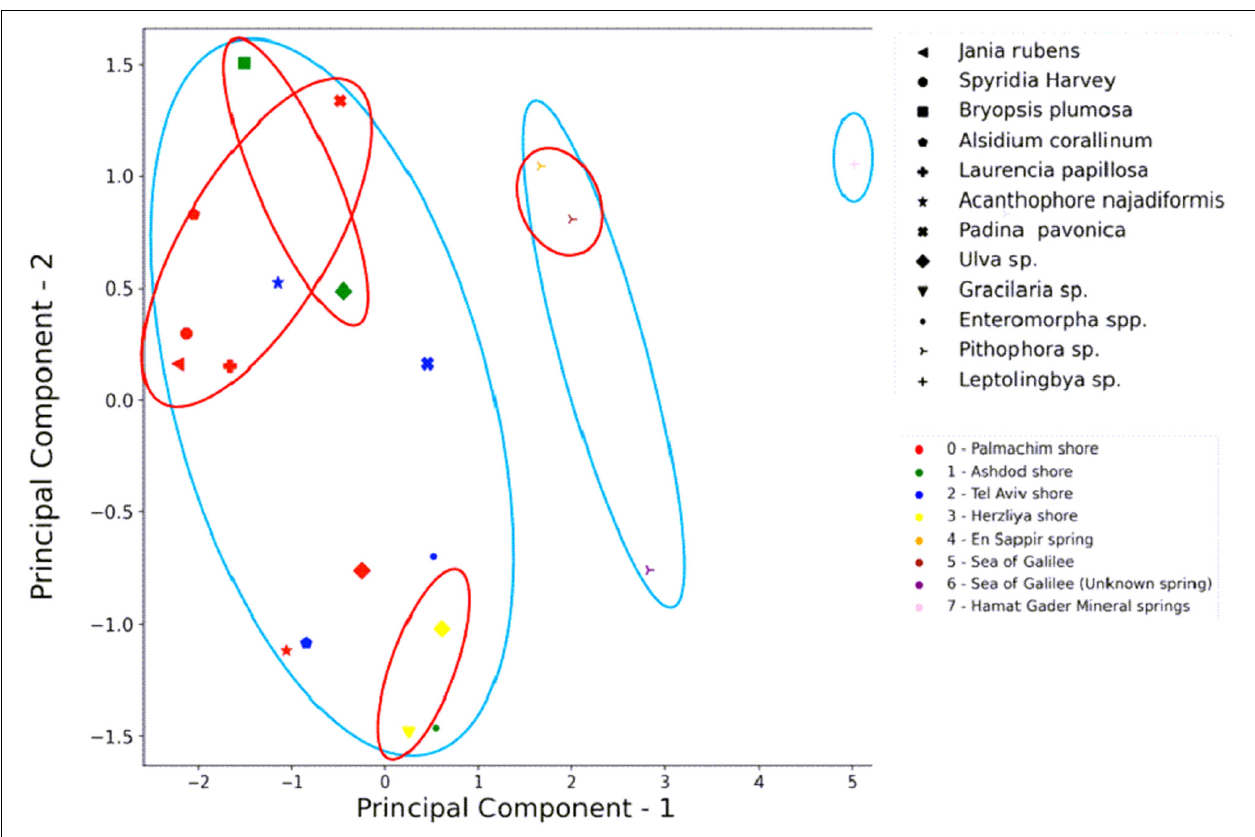
FIGURE 6 | PCA analysis of highly active endophytes (HAE) isolation in regard to habitat, location, and algal genera. HAE isolation from the different algal genera is most influenced by the “habitat” (type of water: marine, freshwater, or thermo-mineral). An influence of the location is noticeable. Component 1 is the “habitat,” component 2 is the HAE isolate incidence. Different shapes represent algal genera. The colors represent the location of algal sampling. Light blue circles are the clustering by habitat (left marine, right thermo-mineral). Red circles are the clustering by